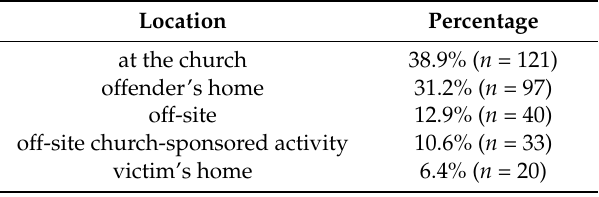
Table 1. Offense